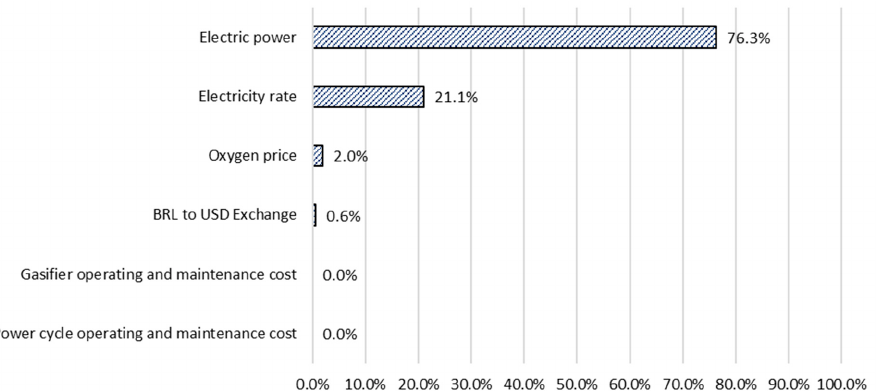
Figure 15. Assumption contribution to NPV variance of power system based on air as a gasifica- tion